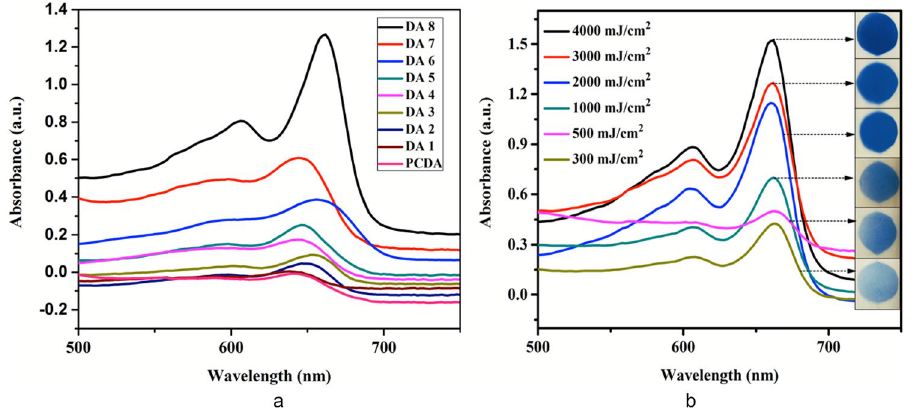
Figure 2. ( a ) Visible spectra of PCDA and DA 1–8 film dosimeters. ( b ) Visible absorption spectra of DA 8 film